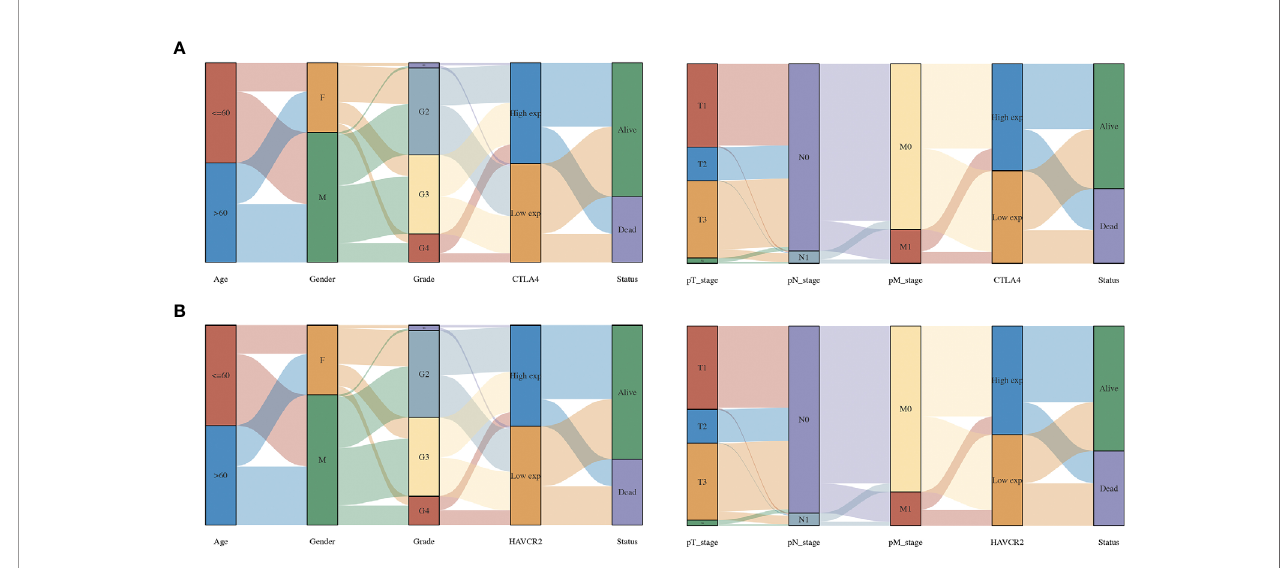
FIGURE 5 | The association between immune checkpoints and the clinical parameters of KIRC patients. (A) The association between CTLA4 and the clinical parameters of KIRC patients. (B) The association between HAVCR2 and the clinical parameters of KIRC patients.